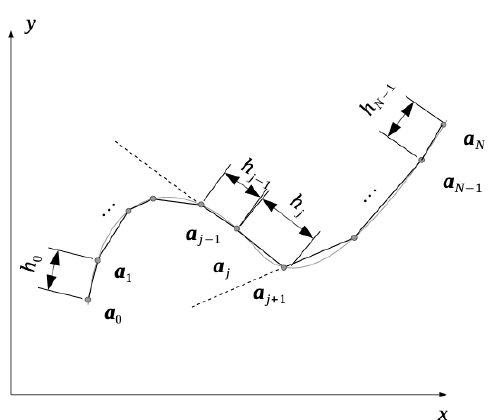
Figure 2. Rectifiable integration